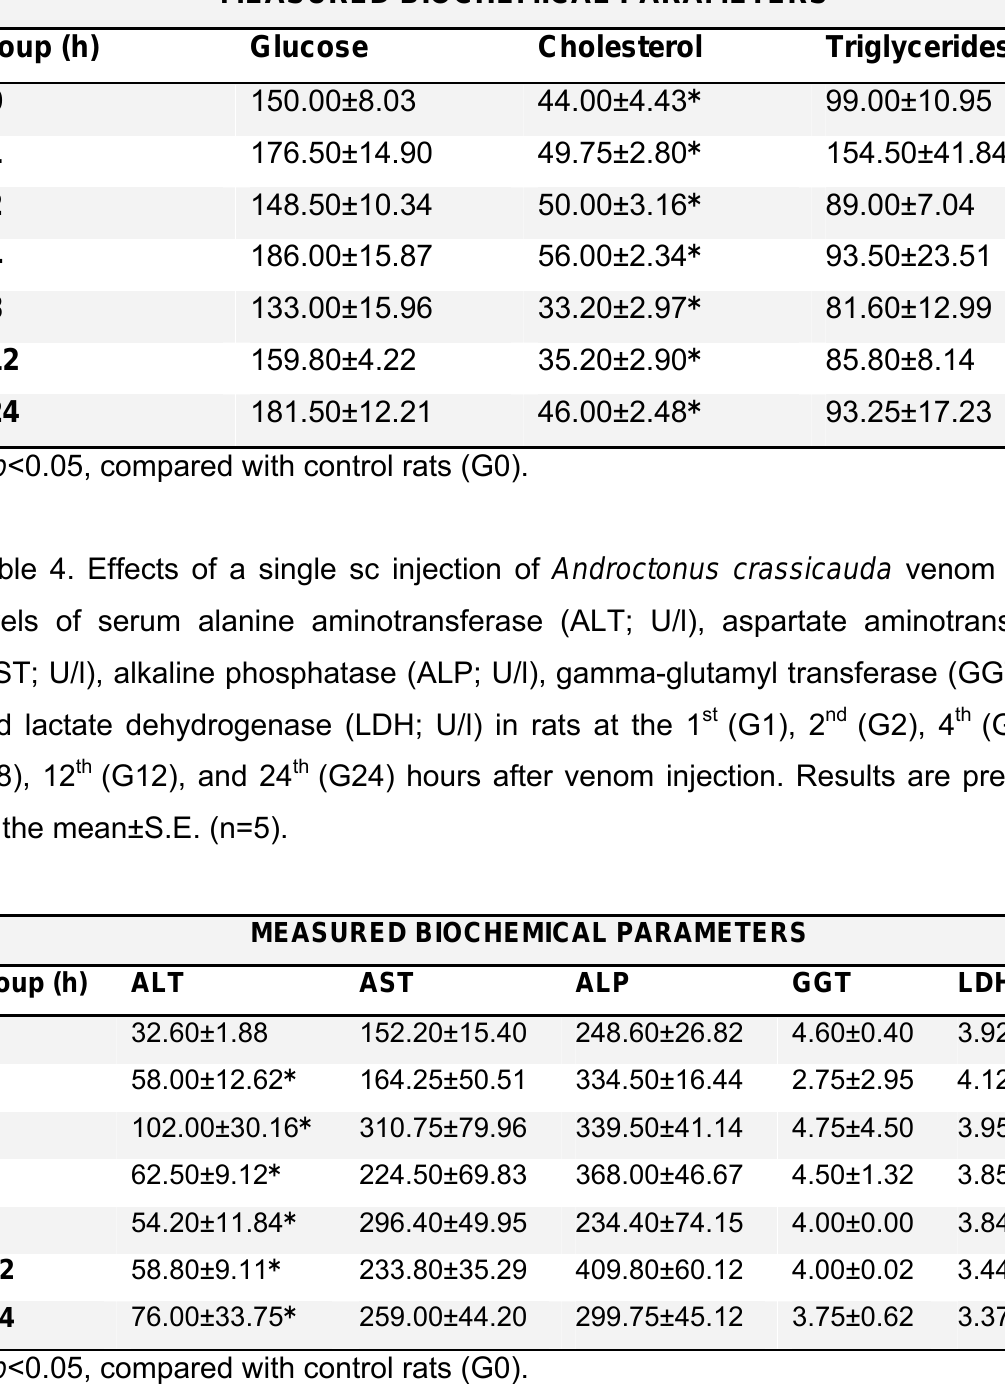
Table 3. Effects of a single sc injection of Androctonus crassicauda venom on the levels of serum total glucose (mg/dl), cholesterol (mg/dl) and triglycerides (mg/dl) in rats at the 1 st (G1), 2 nd (G2), 4 th (G4), 8 th (G8), 12 th (G12), and 24 th (G24) hours after venom injection. Results are presented as the mean±S.E. (n=5).